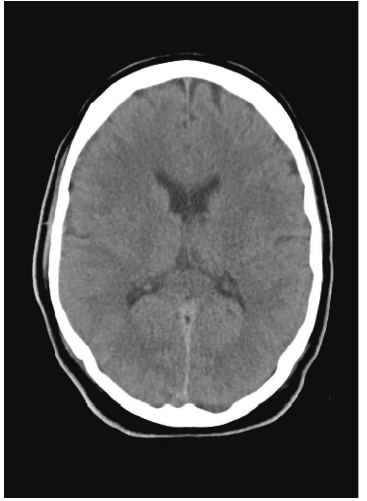
Figure 2: CT of the head without contrast reveals evidence of mild cerebral edema.